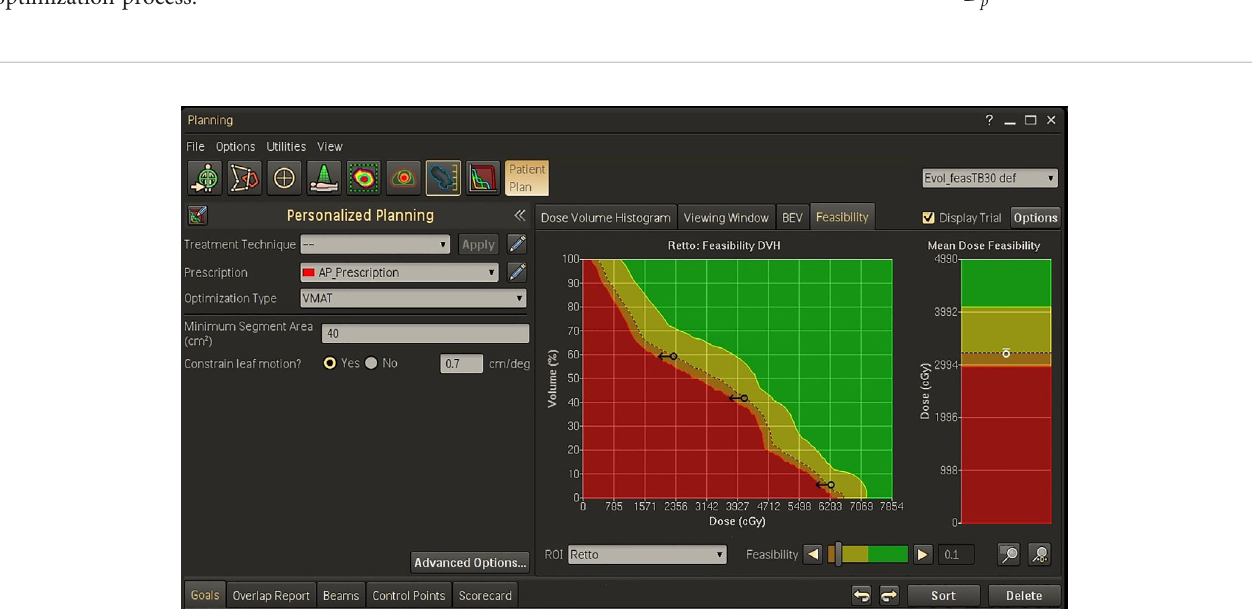
FIGURE 1 | Feasibility dose-volume histogram for rectum in Personalized template for a representative patient. The green, yellow, orange, and red regions in FDVH indicate that the goals are “ achievable ” , “ challenging ” , “ dif fi cult ” , and “ not achievable ” , respectively. In this example, three dose-volume objectives were de fi ned on the f = 0.1 curve (the black arrows) and one objective was set for the mean dose (the white